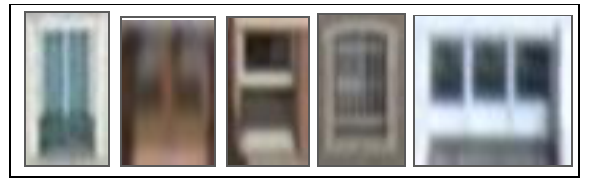
Figure 11. Windows with 1, 2 or 0 "clear" vertical bar